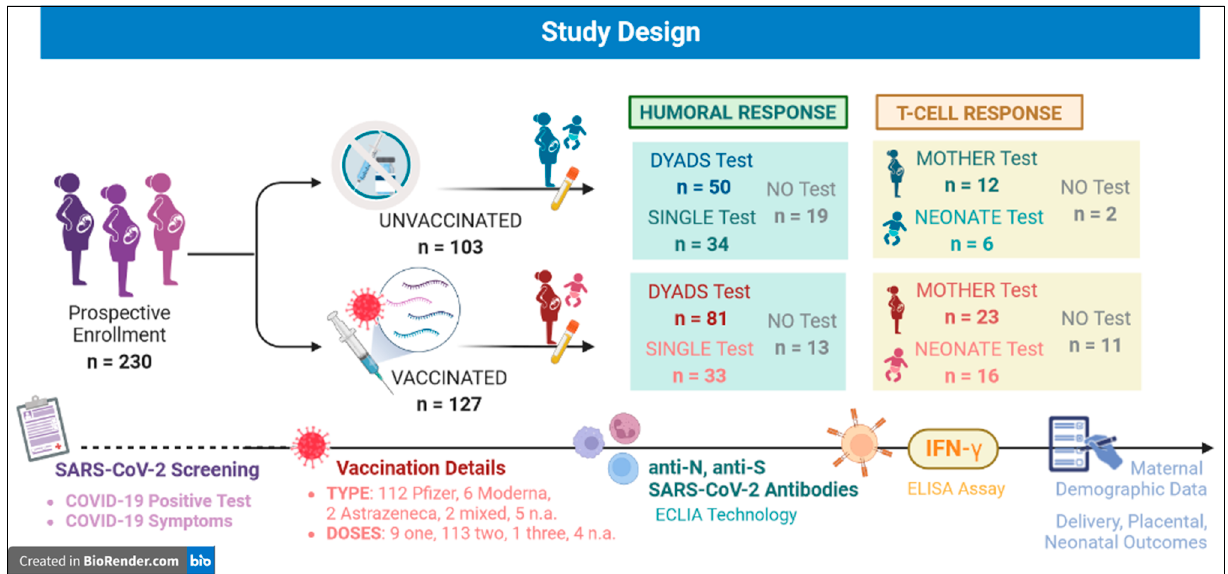
Figure 1. Study design.